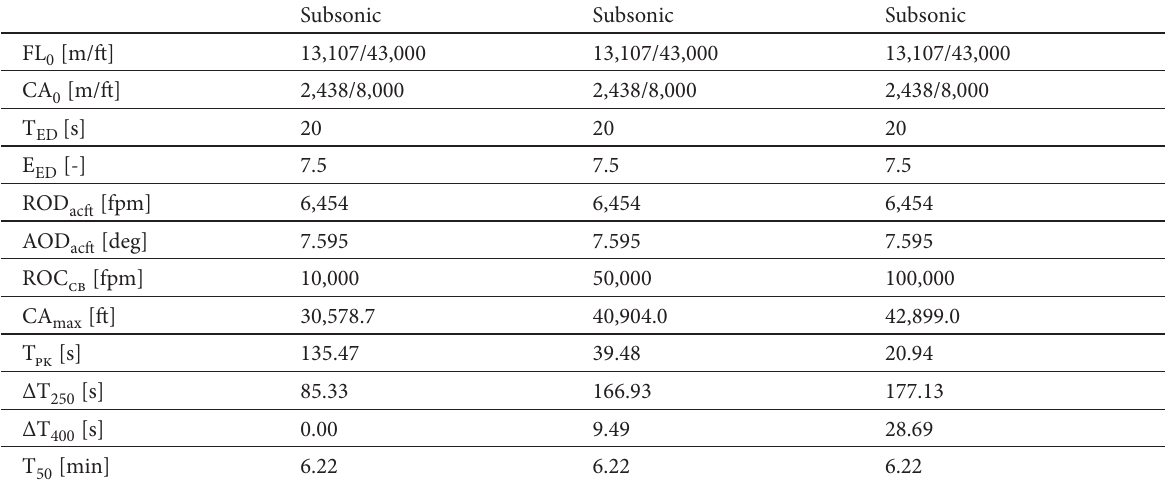
Table 3. Decompression of a particular subsonic aircraft experiencing different decompression magnitudes